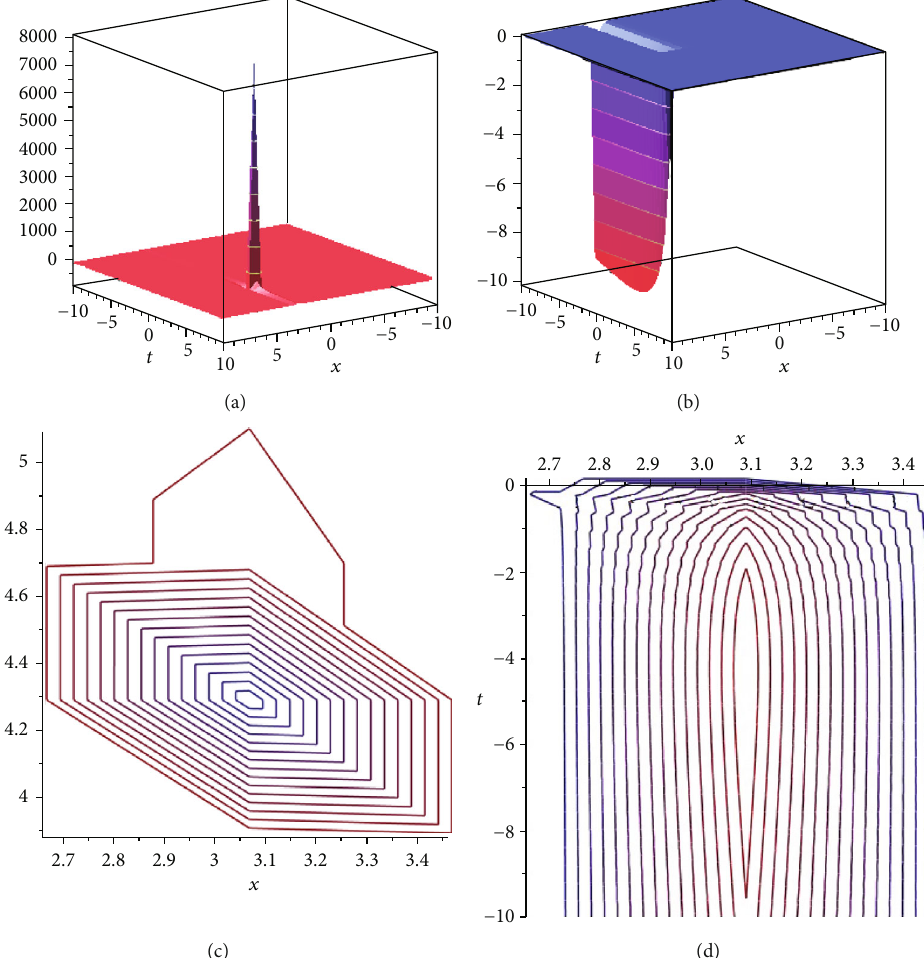
ð x , t Þ : (a) real three-dimensional shape, (b) complex three-dimensional shape, 6